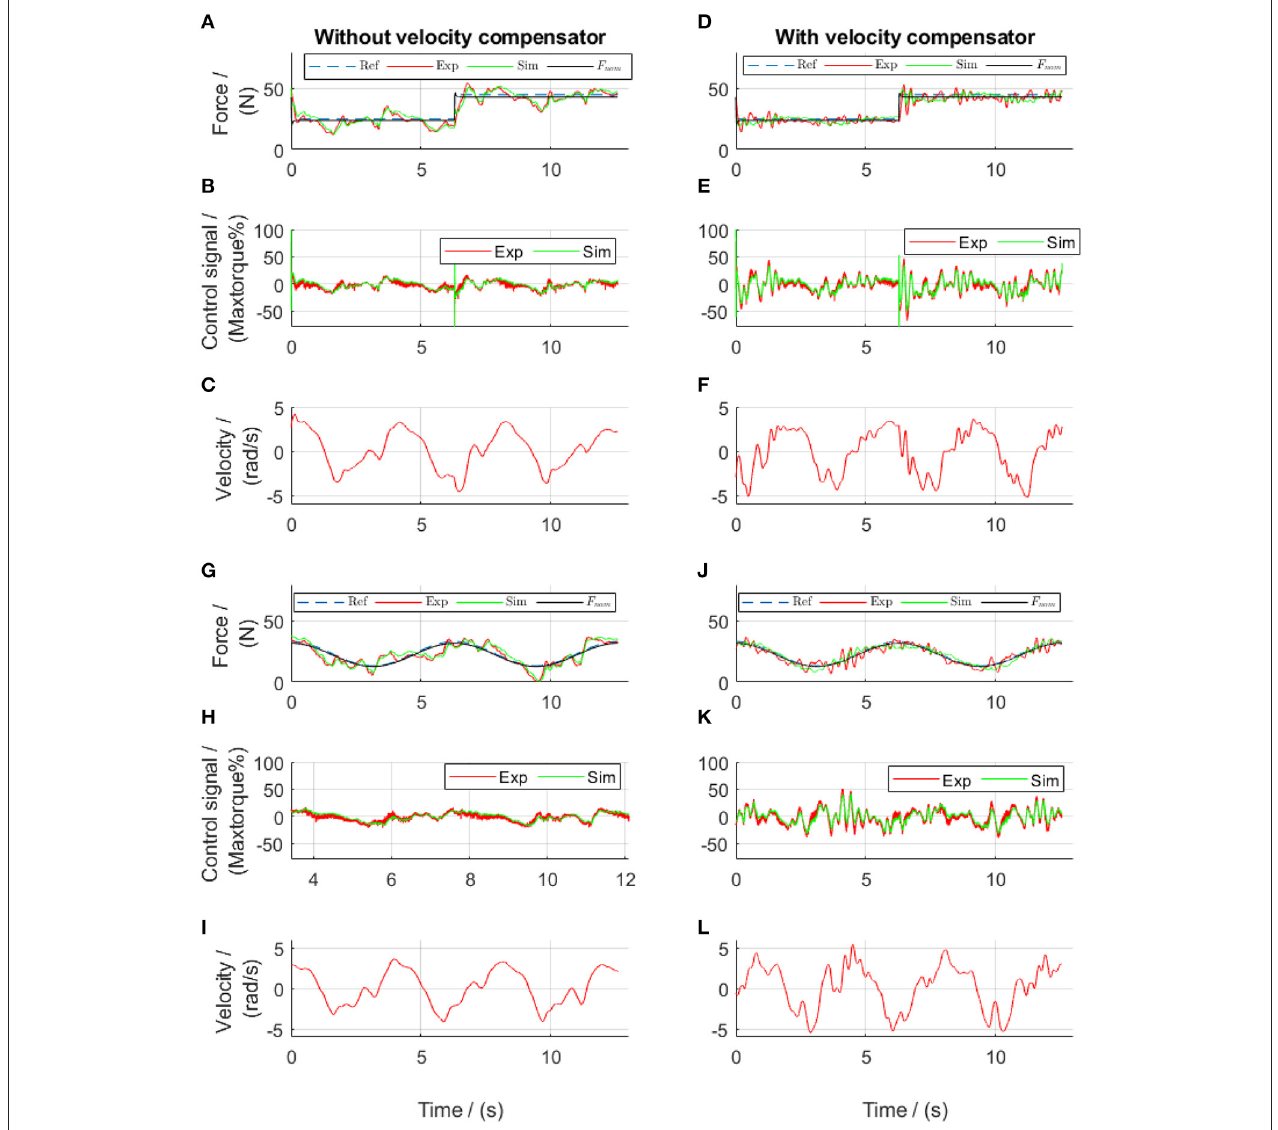
FIGURE 11 | Lead algorithms regulated force control of the front thigh actuator in the dynamic tests. Subplots (A–F) show the results from square-wave reference test, while subplots (G–L) show the results from sinusoidal reference test. Ref, references; Exp, experimental values; Sim, simulation results; F nom , the simulated